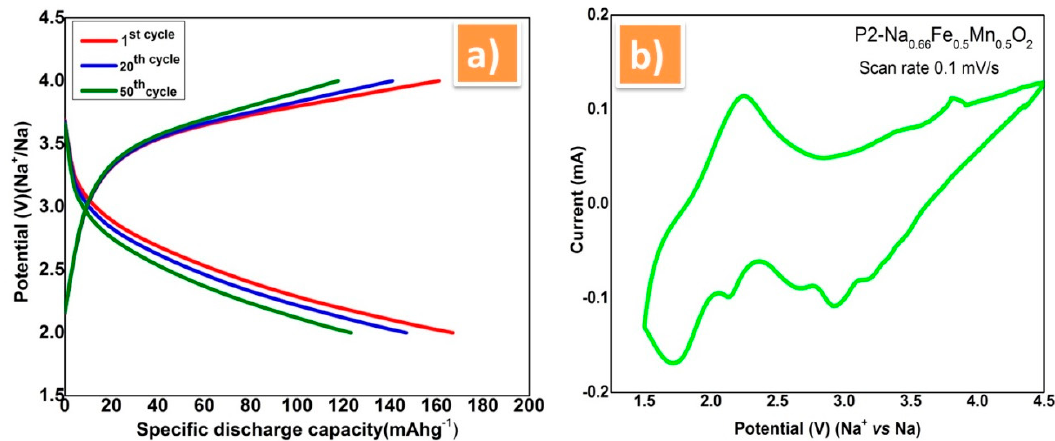
Figure 4. ( a ) Complex impedance spectra of PVdF-SiO 2 , celgard, and cellulose membranes at room temperature; ( b ) ionic conductivity of PVdF-SiO 2 membrane with different values temperature; ( c ) plot of electrolyte uptake with time; and ( d ) temperature-dependent ionic conductivity plot of PVdF- SiO 2 membrane.